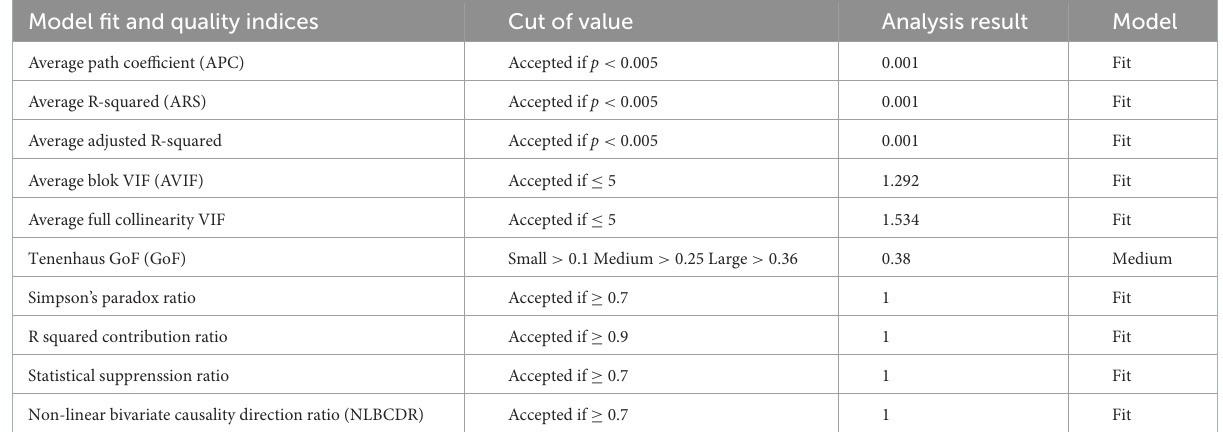
TABLE 5 Model fit and quality indices